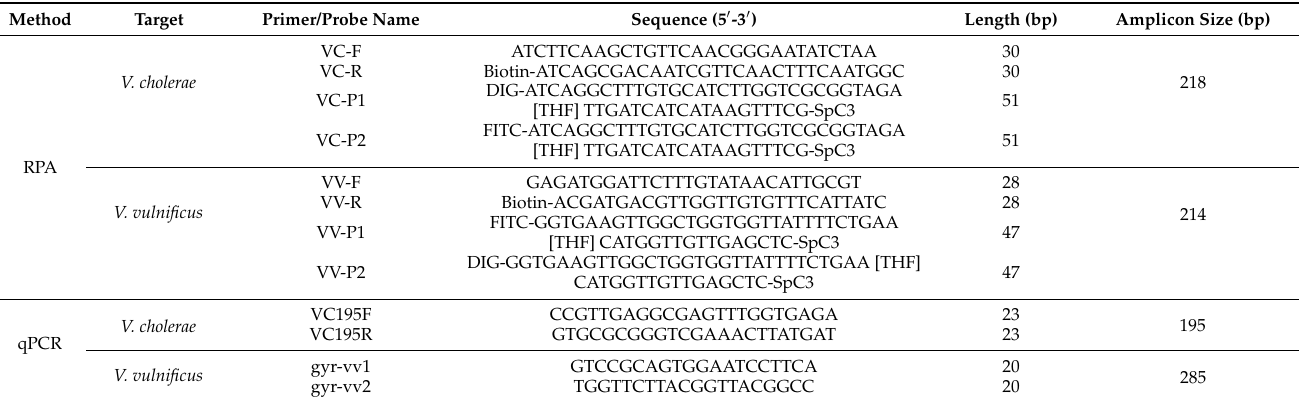
Table 2. Primer and probe